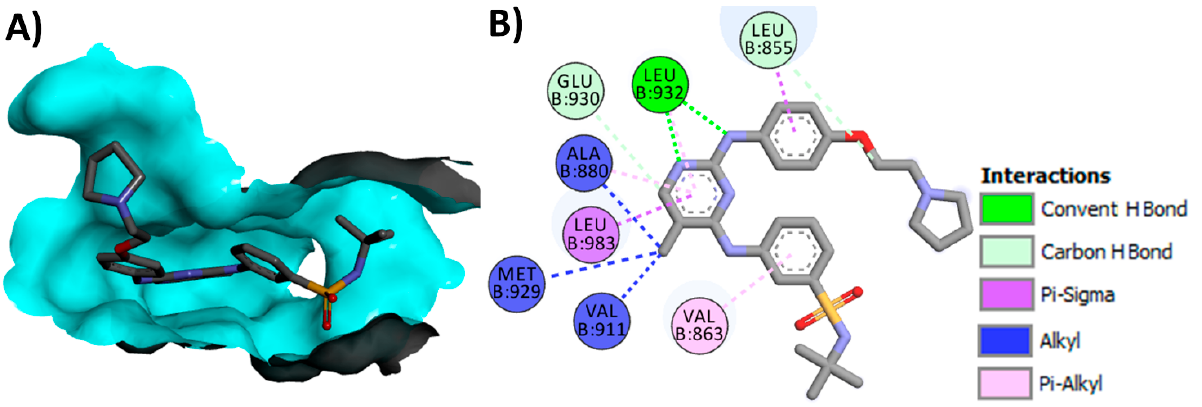
Figure 30. Binding modes of fedratinib (shown as sticks) into JAK2 JH1 (pdb: 6VNE): (A) 3D binding mode, receptor shown as a hydrogen bond surface; (B) 2D binding mode showing different types of interactions with JAK2 JH1; the figure was generated using Discovery Studio Visualizer.